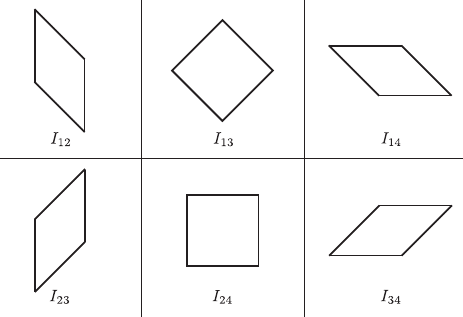
FIG. 6. Prototiles of the Ammann-Beenker tiling and their